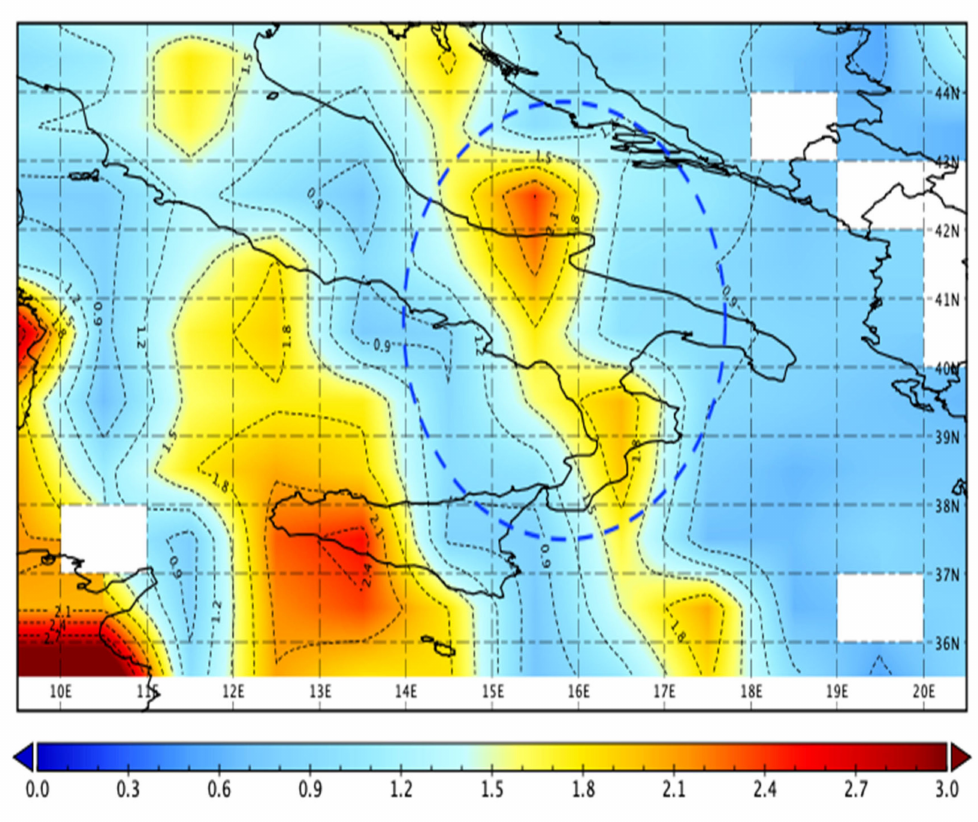
Figure 10. Time averaged map of UV Aerosol Index daily 1 deg. [OMI OMTO3d v003] over 2015-12-04–2015-12-07. The area delimited by the dashed blue line highlights the presence of volcanic aerosols in the domain of interest of this